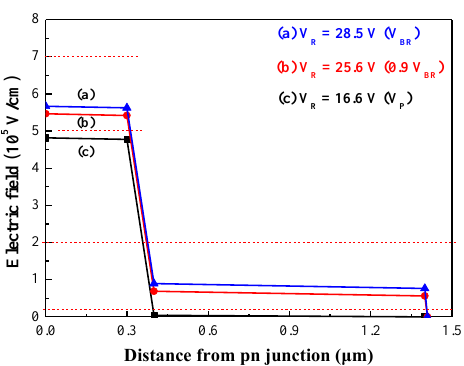
Figure 2. Electric field profile calculated as a function of the distance from the p-n junction under various reverse bias voltages. Table 1. Structural parameters of separate absorption, grading, charge, and multiplication (SAGCM) avalanche photodetector (APD) proposed in this work.